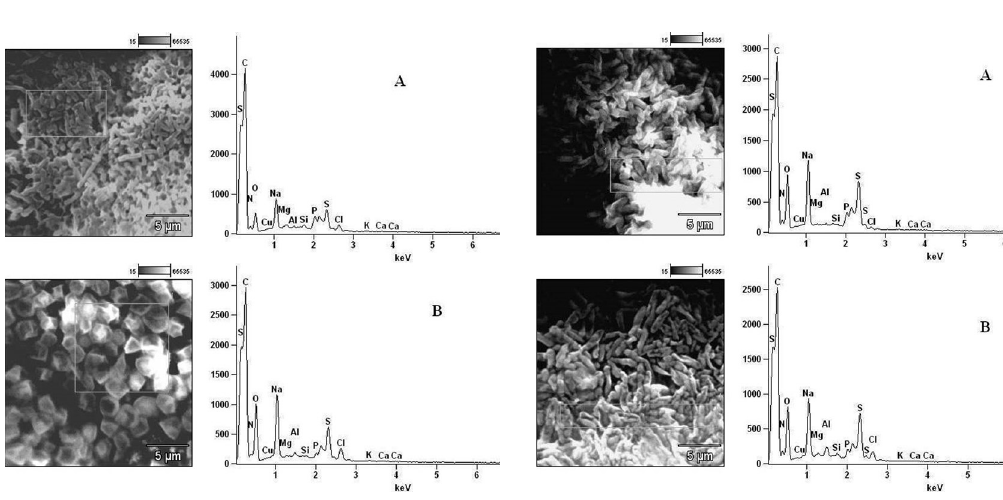
Fig. 8. Elemental components of (A) extract-untreated P. vulgaris and (B) extract-treated P. vulgaris .